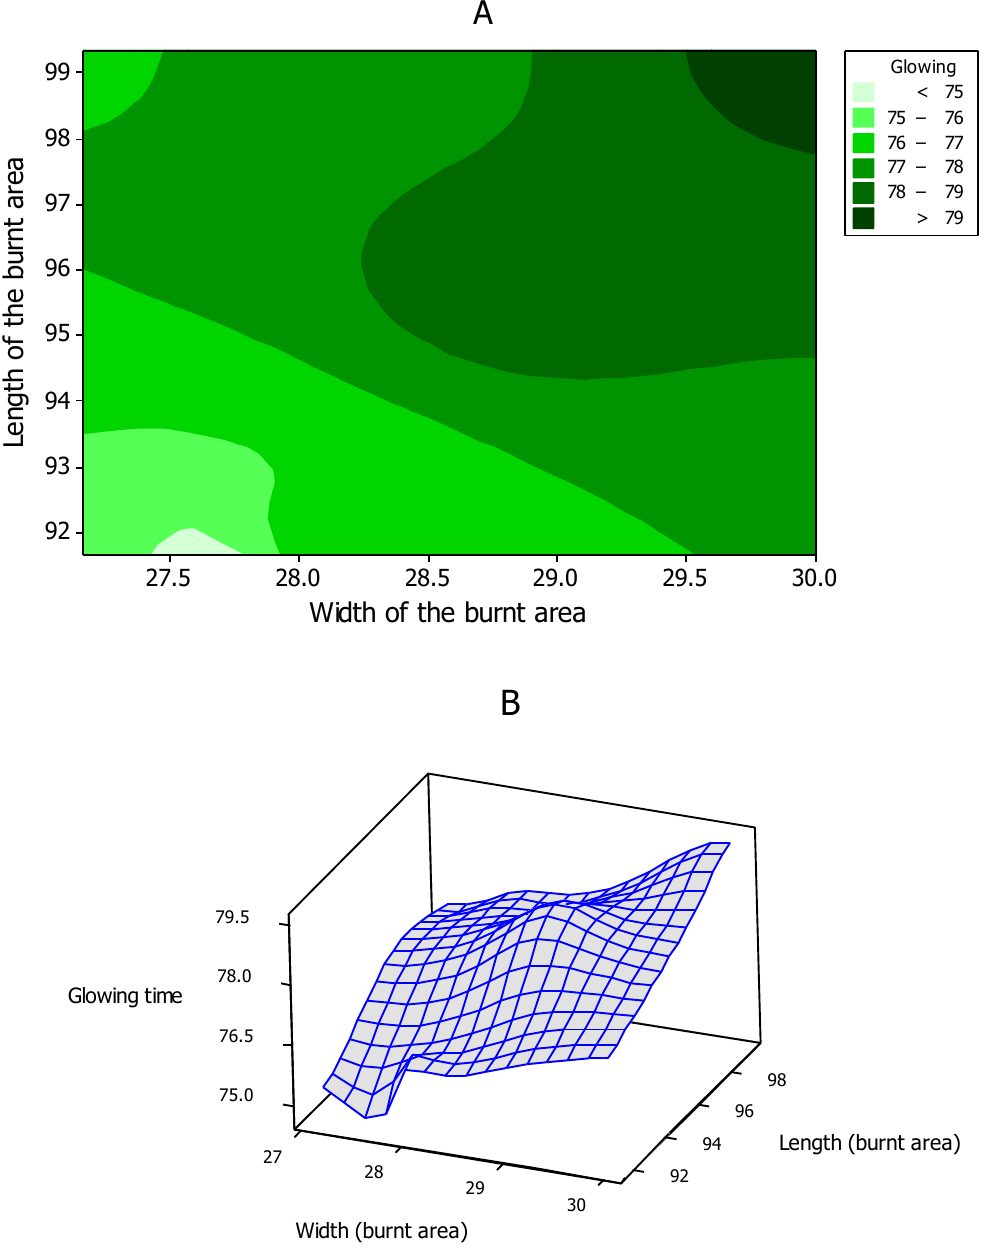
Figure 5. Contour ( A ) and surface ( B ) plots between the fire properties tested in the six particleboard panels made from wood chips and chicken feathers containing 10% wollastonite.